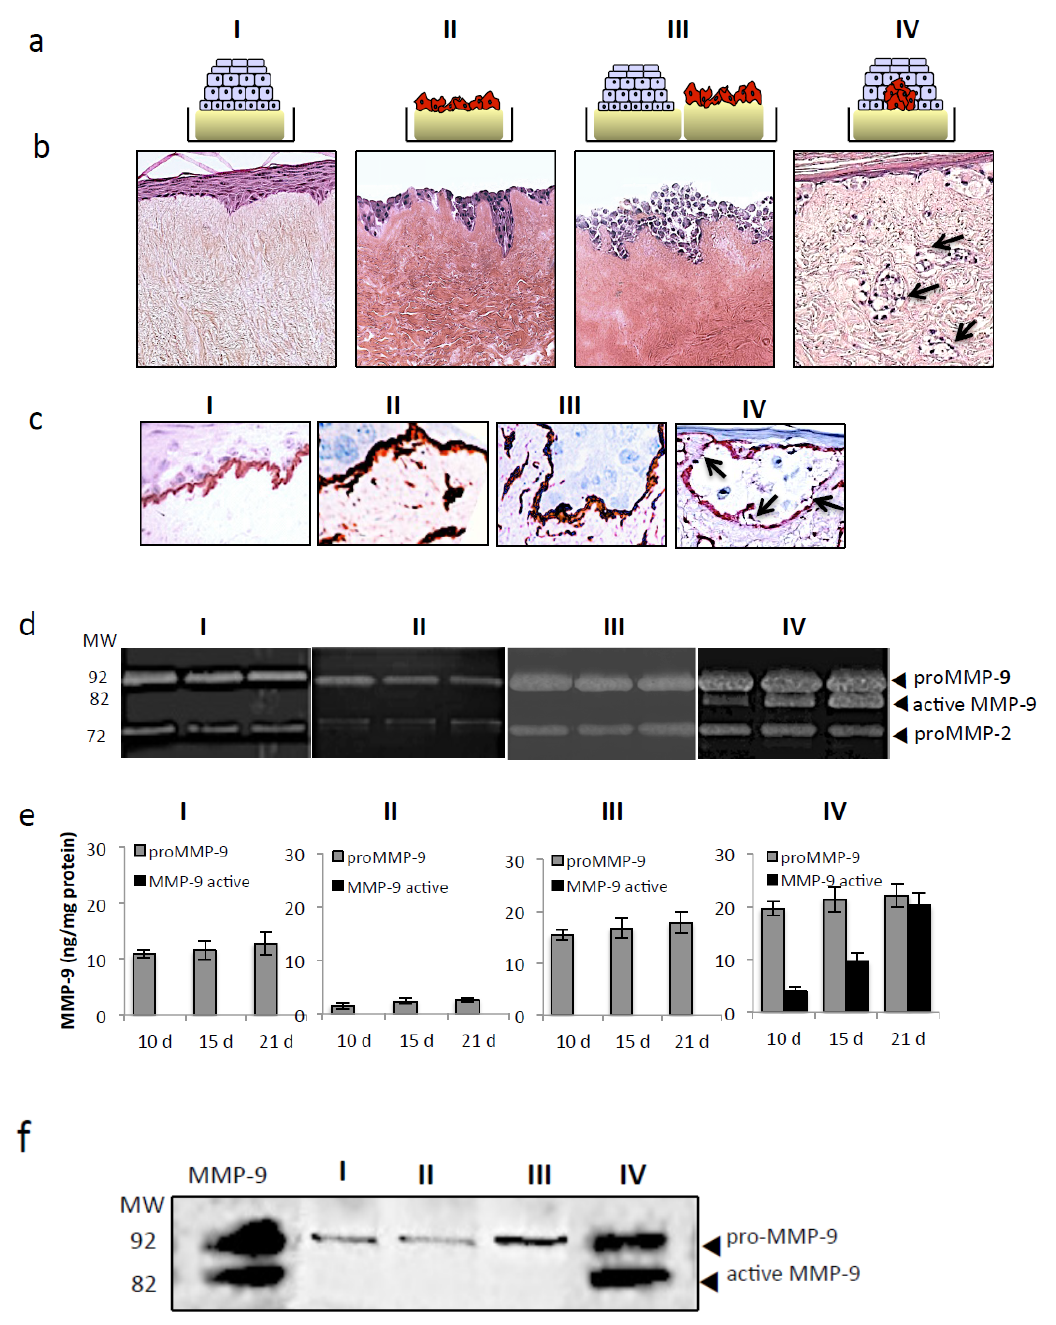
Figure 4. Tspan8-dependent dermal invasion coincides with MMP-9 activity and local dissolution of collagen IV and requires surrounding keratinocytes. ( a ) Schematic drawings of the four di ff erent culture conditions. I: SR containing no melanoma cells; II: Tspan8-expressing cells seeded alone on DED (DeEpidermised Dermis); III: SR without melanoma cells juxtaposed with Tspan8 + cells seeded alone on DED; IV: SR containing Tspan8 + cells in contact with keratinocytes. ( b ) Representative H&E staining of skin composites sections. Arrows indicate melanoma cells infiltrating the dermis. ( c ) type IV collagen staining on sections from the four culture conditions described in ( a ). Arrowhead pointed to collagen IV destruction. ( d – f ) Serum-free media from the four culture conditions collected at day 10, 15 and 21 were analyzed for the expression levels of proMMP-9 and active MMP-9 using gelatin zymography ( d ), ELISA ( e ) and western blot ( f ).